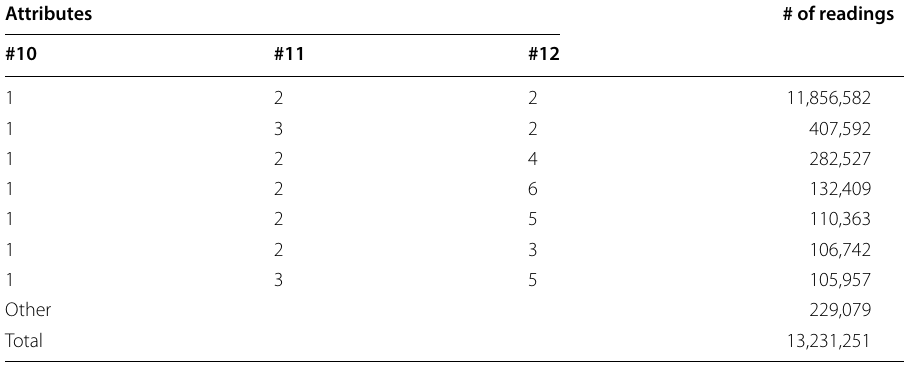
Table 4 Readings: main categories (with relative amount of readings)